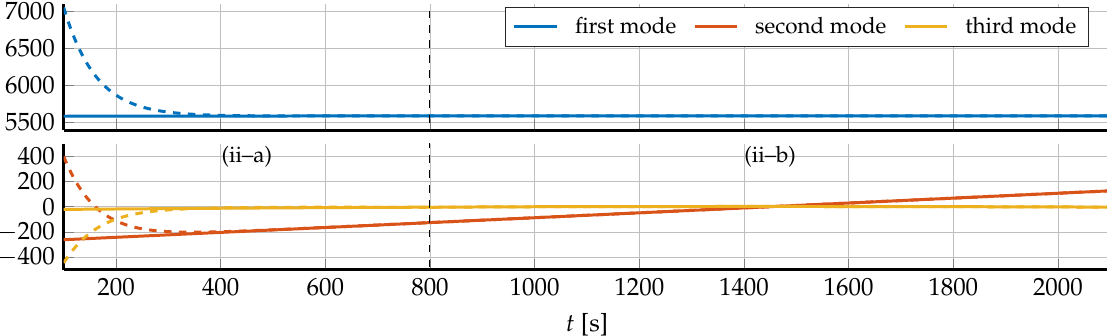
Figure 8. Extrapolated (solid) and projected (dashed) coefficients of the shifted temperature modes for the left-traveling wave.